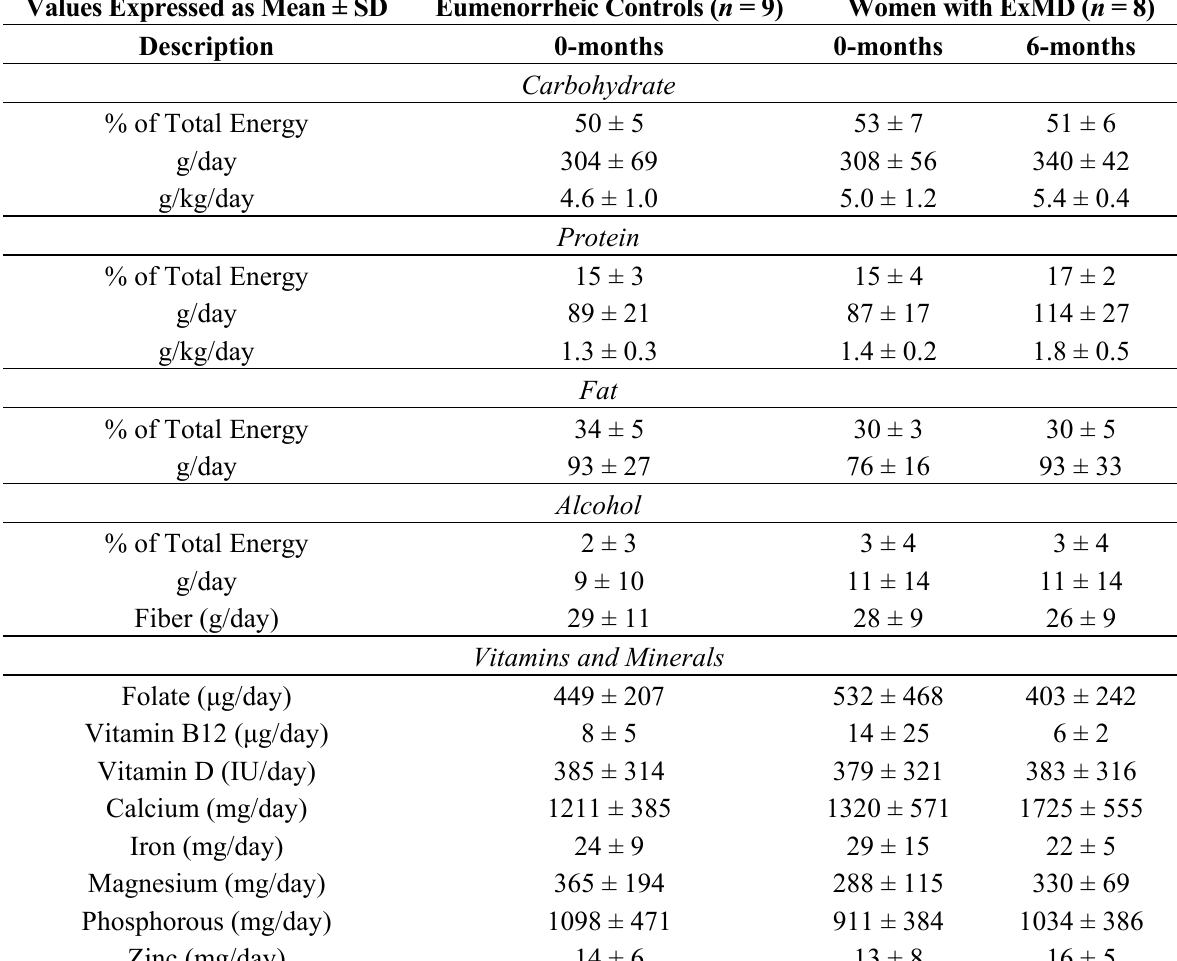
Table 3. Nutrient intakes in athletes with eumenorrheic (Eumen) or exercise-induced menstrual dysfunction (ExMD) before and after a 6-month dietary intervention a–c